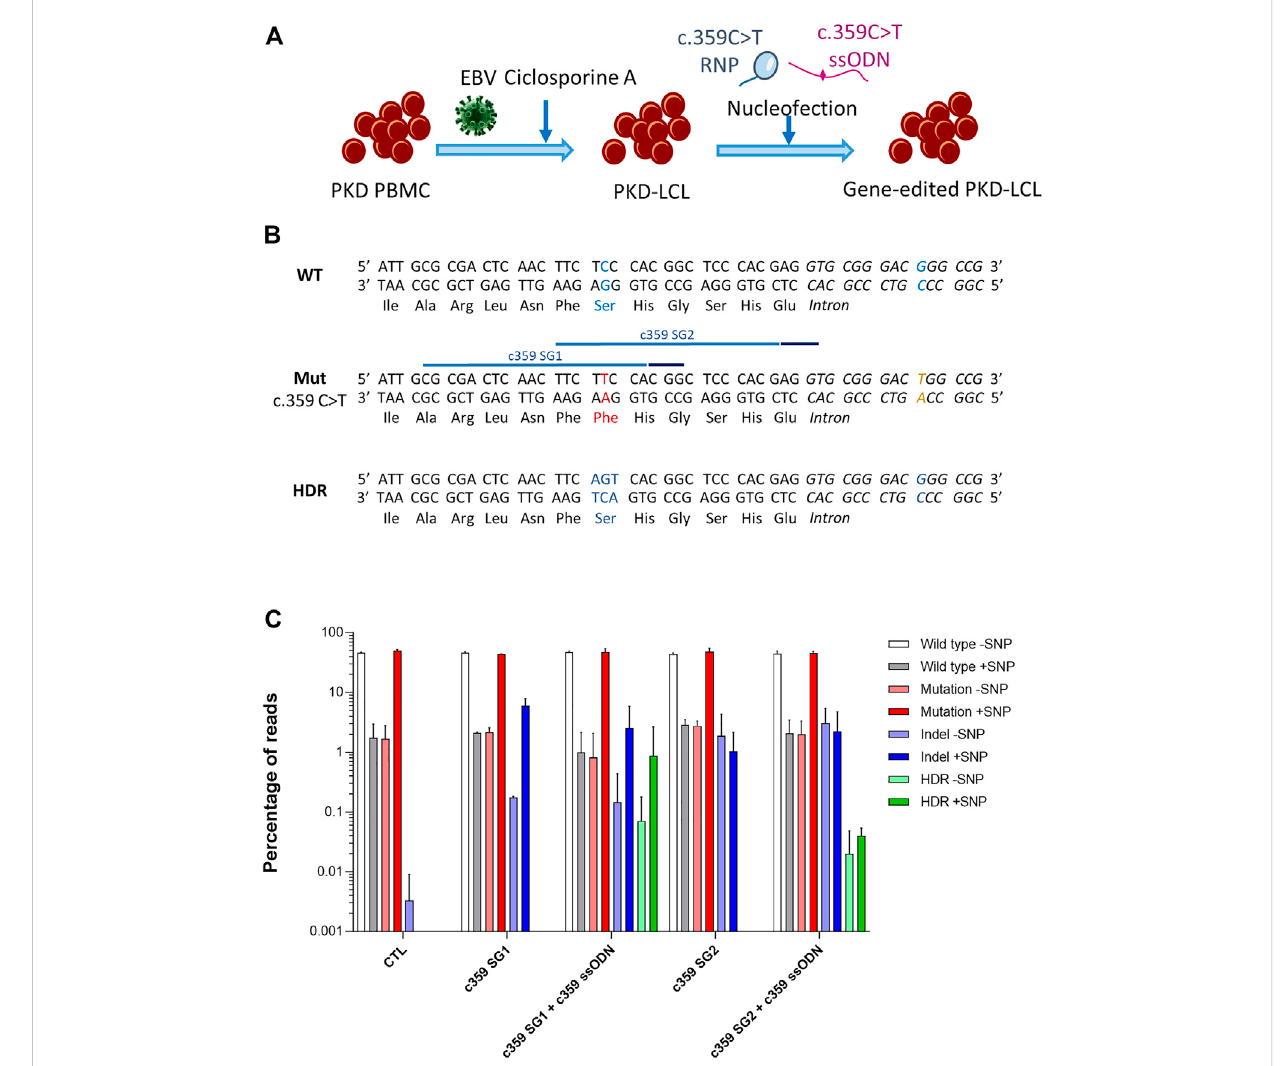
FIGURE 1 Correction of the c.359 C > T point mutations present in PKD-derived lymphoblastic cell line. (A) Scheme shows the generation of PKD lymphoblastic cell line and the nucleofection with the mutation-speci fi c gene editing tools. (B) Genomic sequences of the wild-type allele show the wild-type nucleotide and amino acid in blue (top panel), the mutated allele with the c.359 C > T mutation and the mutated amino acid in red, along withthemutation-associatedSNPinyellow(middlepanel)withthetargetsequencesofthetwogRNAtargetingthemutation(lightblueline)and their PAM sequences (dark blue line), and the precise gene editing output with the modi fi ed nucleotides and reverted amino acid in blue (bottom panel). (C) Frequency of the different reads identi fi ed by Next-Generation Sequencing in PKD-LCLs gene edited with the speci fi c gene editing tools for c.359 C > T mutation. Frequency values are represented as percentage of reads in the y -axis. Data are obtained from up to six independent experiments (N = 3 for CTL, N = 2 for c359 SG1, N = 9 for c359 SG1 + c359 ssODN and N = 2 for c359 SG2 and c359 SG2 + c359 ssODN). Data are presented by mean ± SD. Signi fi cance was analyzed by ANOVA with Turkey ’ s multiple comparison